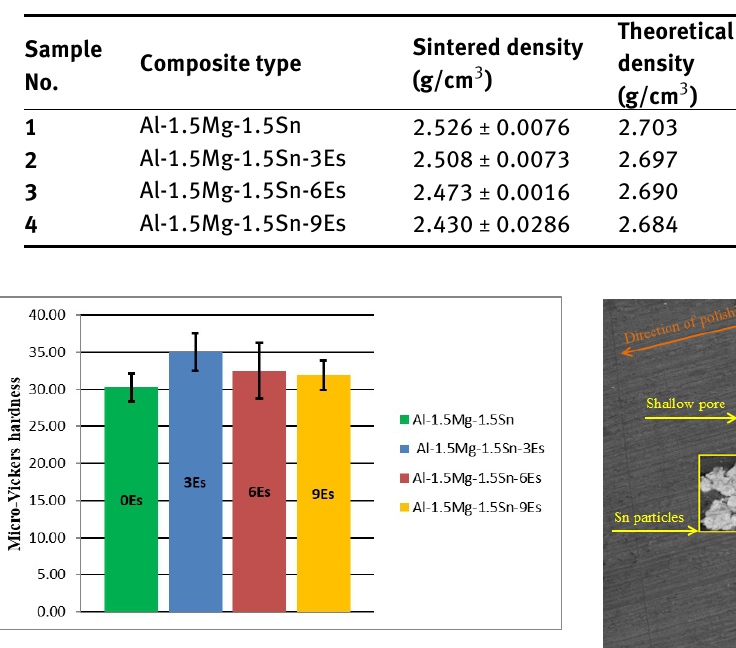
Figure 7: The hardness values against eggshells content in Al- 1.5Mg-1.5Sn-(X)Es composites.